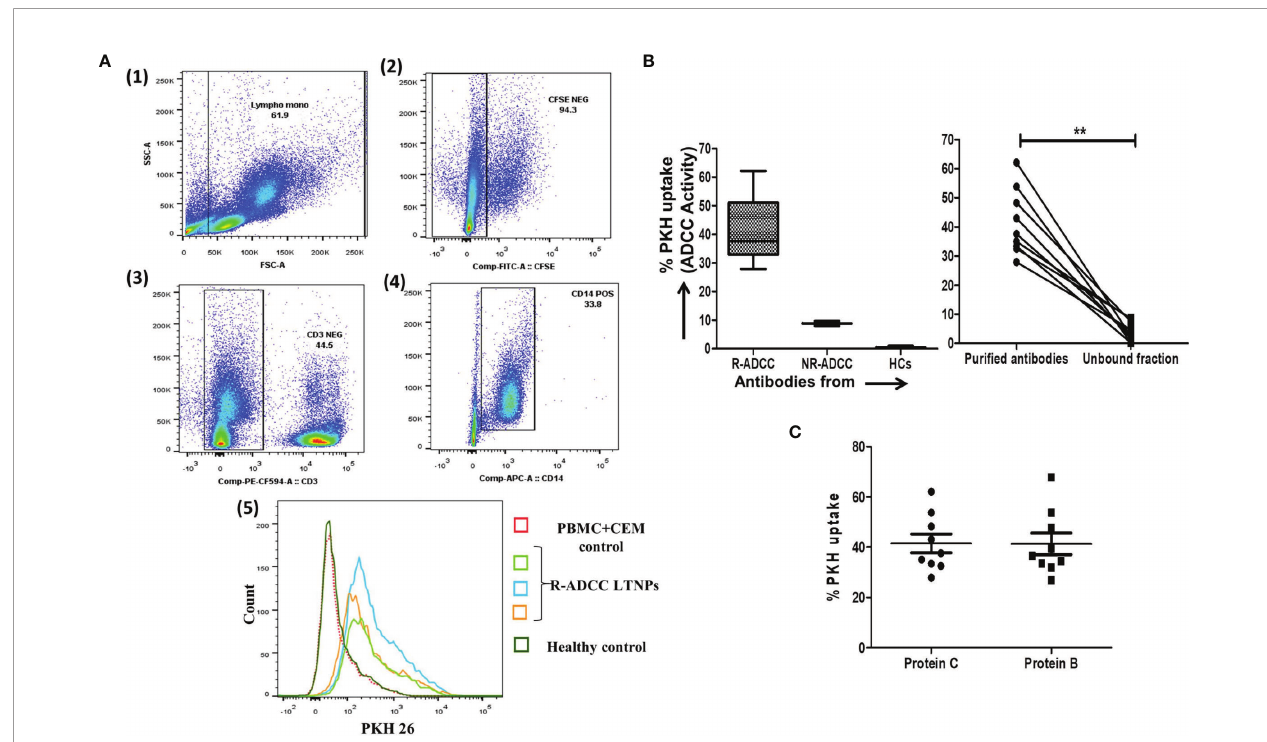
FIGURE 3 | Assessment of ADCC activity of the generated antibodies. (A) The dot plots represent the gating strategy used for the RF-ADCC assay. The CFSE neg cells (2) were gated from FSC/SSC scatters (1) which were drilled down to gate CD3 − cells (3). The CD14+ monocytes (4) were then gated from CD3 − cells and further analyzed for PKH expression. The histogram shows the comparison of PKH26 uptake by CD14 + monocytes in the presence of puri fi ed antibodies generated from gp140-speci fi c memory B cells from R-ADCC LTNPs (R2: green line, R4: blue line, and R5: orange line), HIV-seronegative (dotted line), and in PBMC+CEM control (red line) (5). (B) The box and whiskers plots (left panel) depict the ADCC activity (expressed in terms of % PKH uptake by monocytes) against HIV-1 Env C protein (left panel) ( Y -axis) in R-ADCC ( n = 10) and NR-ADCC ( n = 3) LTNPs and HIV-negative individuals ( n = 3) ( X -axis). Boxes show median (IQR). The line diagram (right panel) shows the paired data of ADCC activity ( Y -axis) of puri fi ed antibodies and their respective unbound fractions from R-ADCC LTNPs ( X -axis) against HIV-1 Env C protein (right panel). (C) The scatter dot plot (lines showing the median with IQR) shows the ADCC activity ( Y -axis) against Env C and Env B protein ( X -axis) of puri fi ed antibodies generated from gp140-speci fi c memory cells of R-ADCC LTNPs ( n = 10). The Wilcoxon matched-pairs t -test was used for the data analysis and p ≥ 0.05 was considered to be signi fi cant for all the analyses. The ** represents P ≤